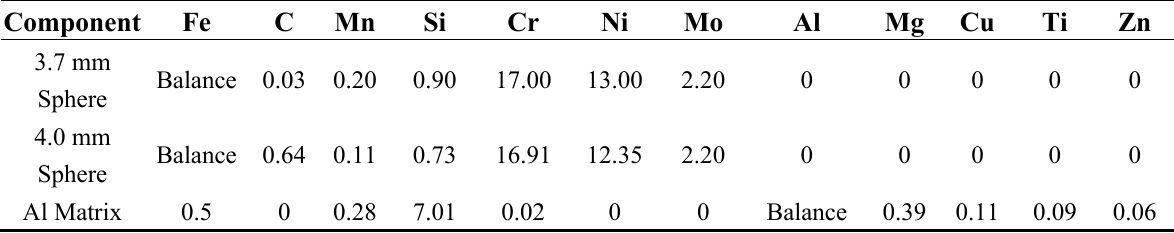
Table 1. Composition (wt%) of hollow spheres and aluminum used in manufacturing aluminum-steel composite metal foams (Al-S